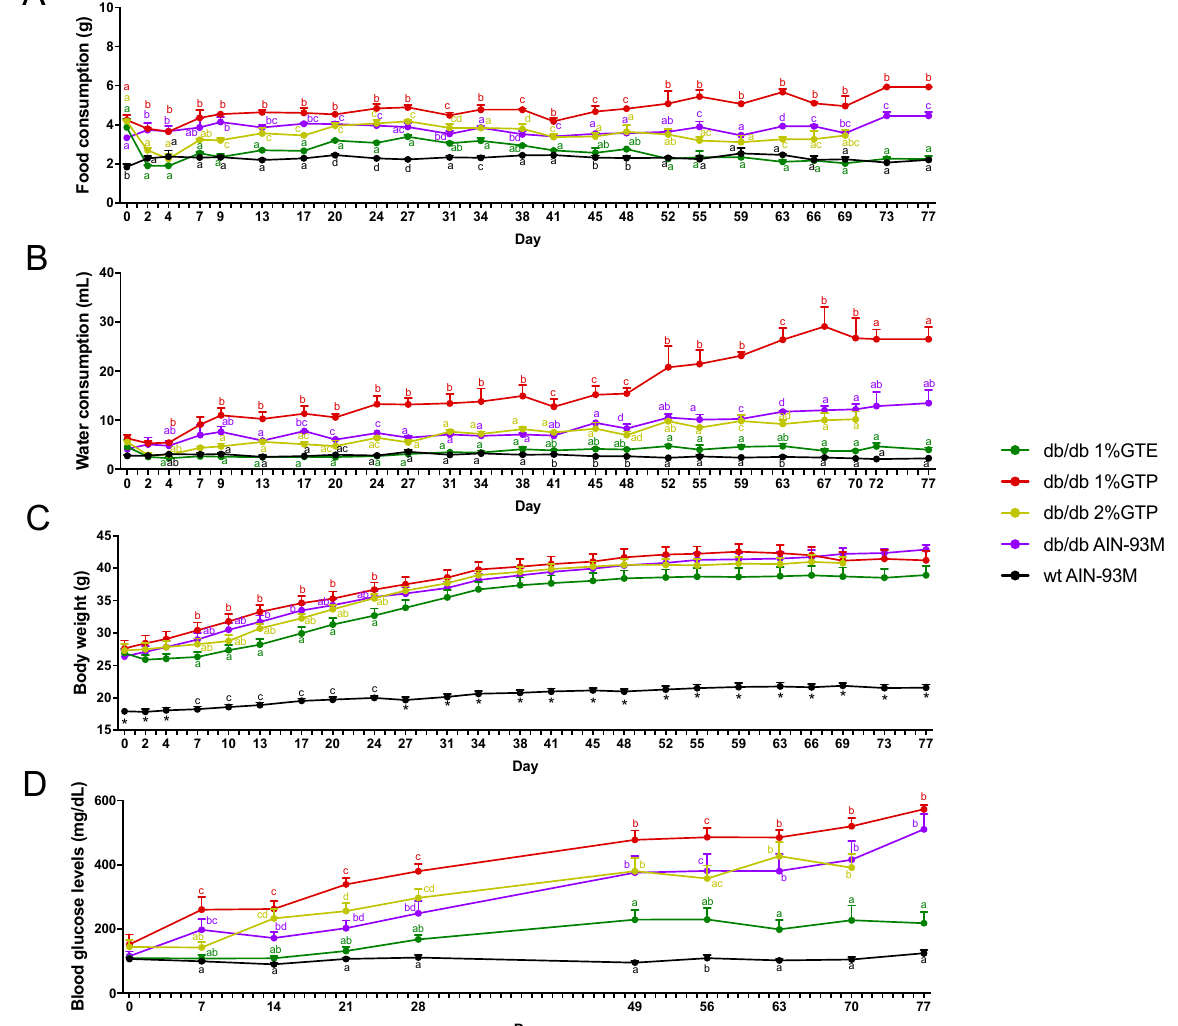
Figure 1. Effects of GTE (green tea extracts) and GTP (green tea leaves in powder form) treatment on mouse food consumption ( A ), water consumption ( B ), body weight ( C ) and fasting blood glucose ( D ). At each time point, ANOVA was performed followed by Tukey’s post-hoc analysis. Data points not sharing common compact letters were significantly different from each other ( p < 0.05). The data are shown as mean ± SE. For panel ( C ), time points with asterisks show that db/db mice had a significantly higher body weight than the wildtype group and there was no difference between the 4 db/db groups. “*” showed significant difference.